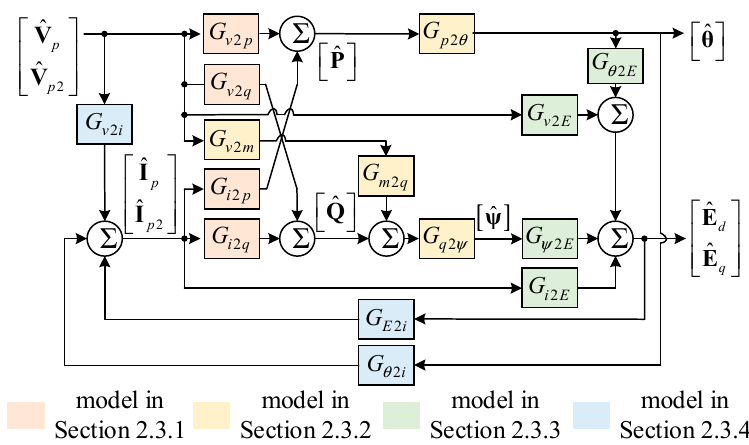
Figure 2. Small-signal relationship in the VSG controlled converter system.